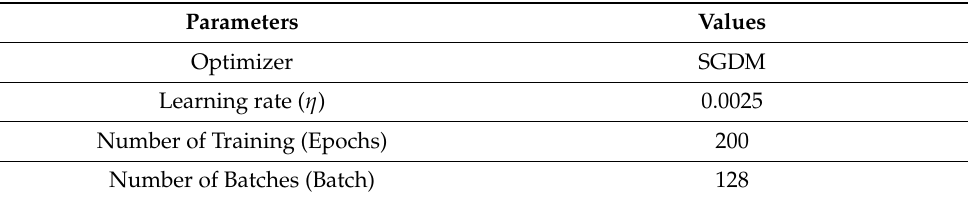
Table 7. P-MLP model feature evaluation training parameters.